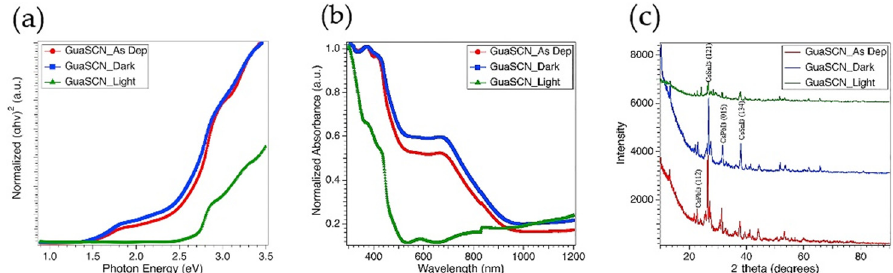
Figure 6. ( a ) Direct bandgap spectra shown in Tauc plot for as-deposited film (red), dark exposed film (blue), and light-exposed film (green). All of these are GuaSCN added films; ( b ) Uv-Vis absorption spectra; ( c ) XRP pattern for mixed Sn-Pb films with GuaSCN before and after stability testing. Y-axis represents X-ray intensity in counts per second (CPS).